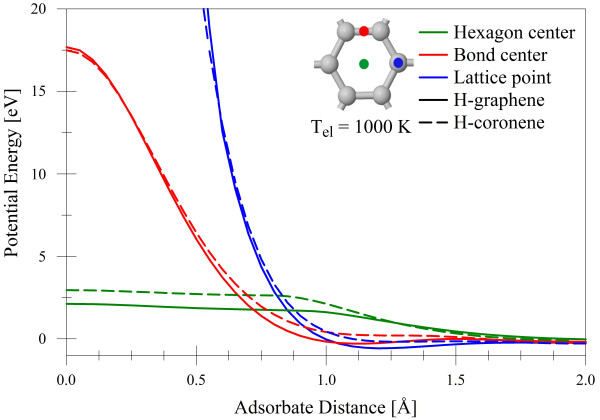
Potential energy of the H-graphene and H-coronene interactions at analogous points in the lattice. As calculated by the SCC-DFTB with the PBC-0-3/ZBL parameters.